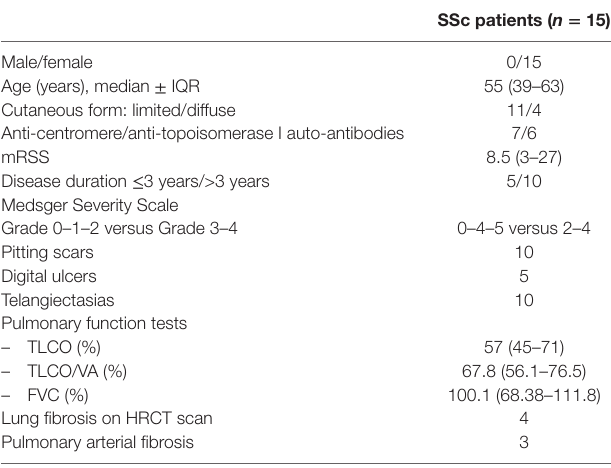
Table 1 | Characteristics of the